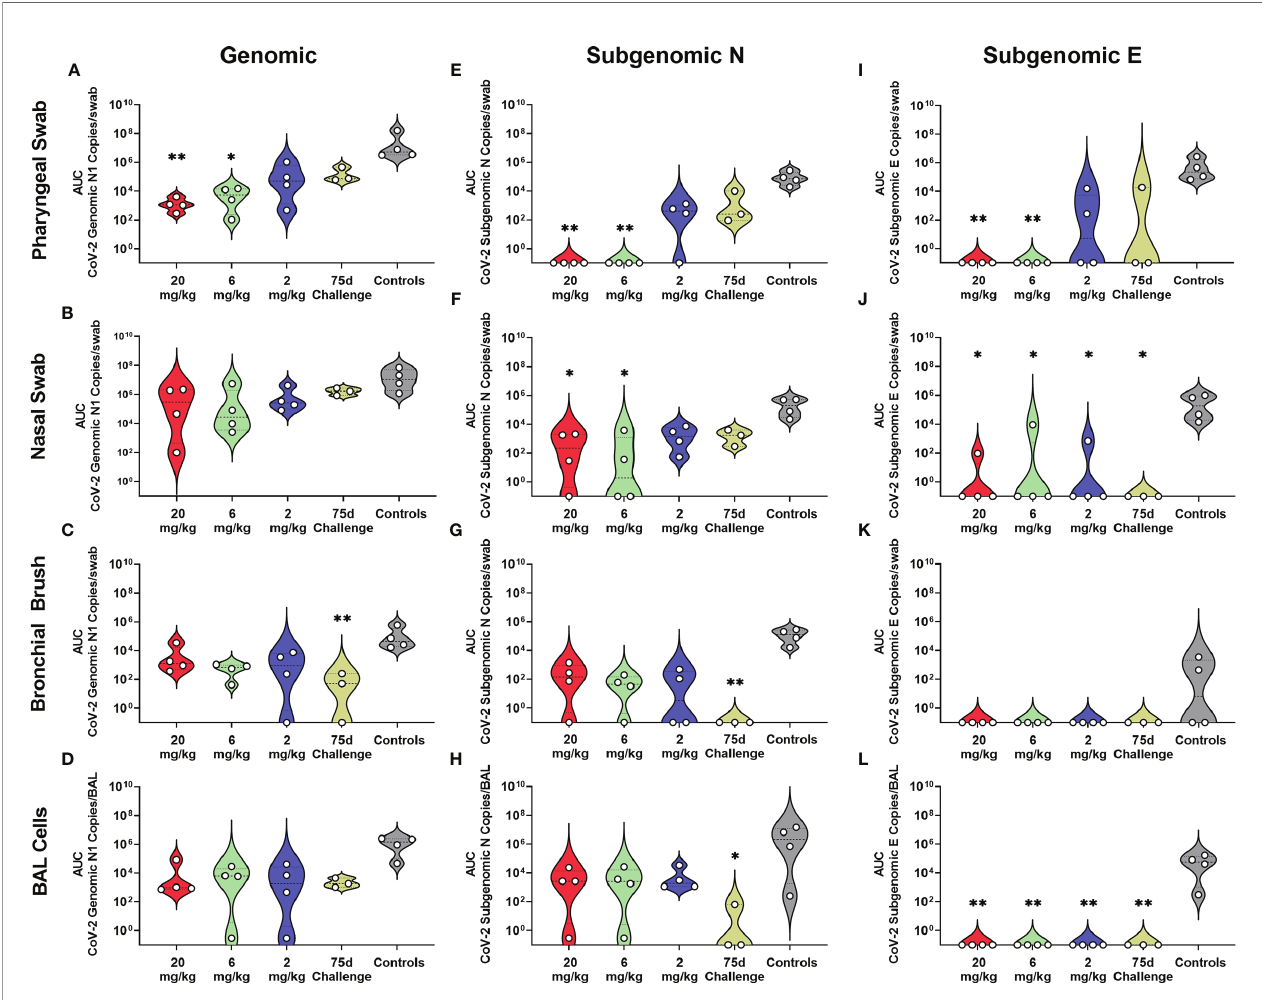
FIGURE 2 | Viral Loads Assessed via Genomic and Subgenomic RT-qPCR During Challenge. Viral loads from pharyngeal swabs (A, E, I) , nasal swabs (B, F, J) , bronchial brushes (C, G, K) and BAL cells (D, H, L) assessed by RT-qPCR for genomic N (A – D) , subgenomic N (E – H) , and subgenomic E (I – L) content. Data are represented as area under the curve of each dosage group for each anatomical site and assay type. Groups were compared via Kruskal-Walis test comparing each dosage group to the control group. Asterisks represent signi fi cant difference from controls (*p < 0.05; **p <